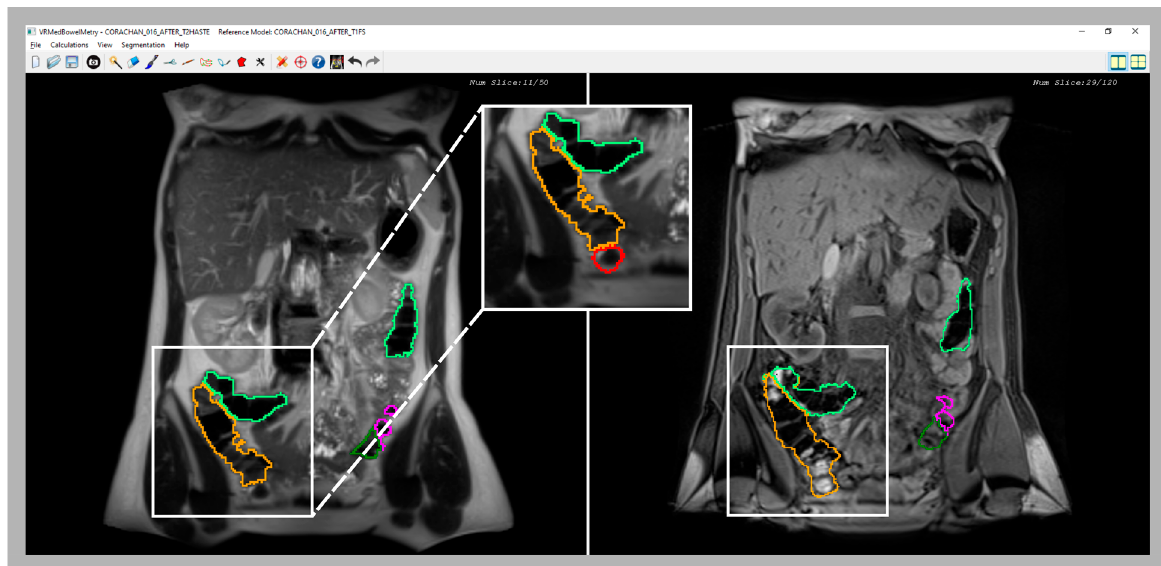
Figure 6. Comparative images of a confusing area of the cecum in T2 ( left image) and T1-FS ( right image) sequences. Note that in the T2 sequence, part of cecum was not included in the initial segmentation because it was confused with the small bowel; a zoom (central image) provides a better visualization of the non-included area (red line). However, in the synchronized visualization with the T1 sequence ( right image), the feces facilitate the cecum demarcation. Therefore, using the new inspection module, the medical specialist should be able to correct and include the cecum in the final segmentation.